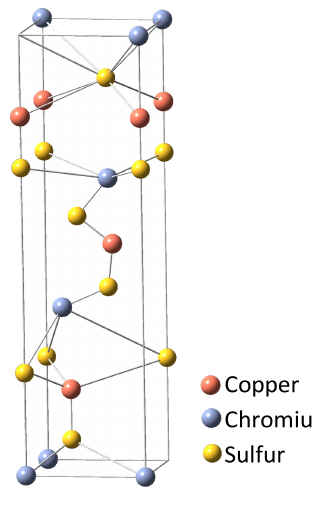
Figure 10: Crystal structures of CuCrS 2 .